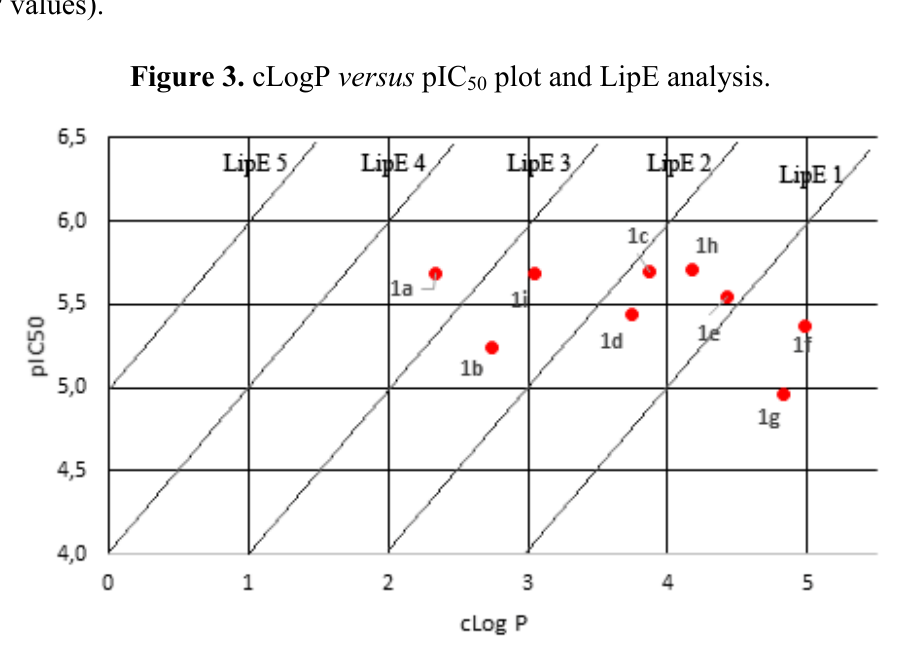
Figure 3. cLogP versus pIC